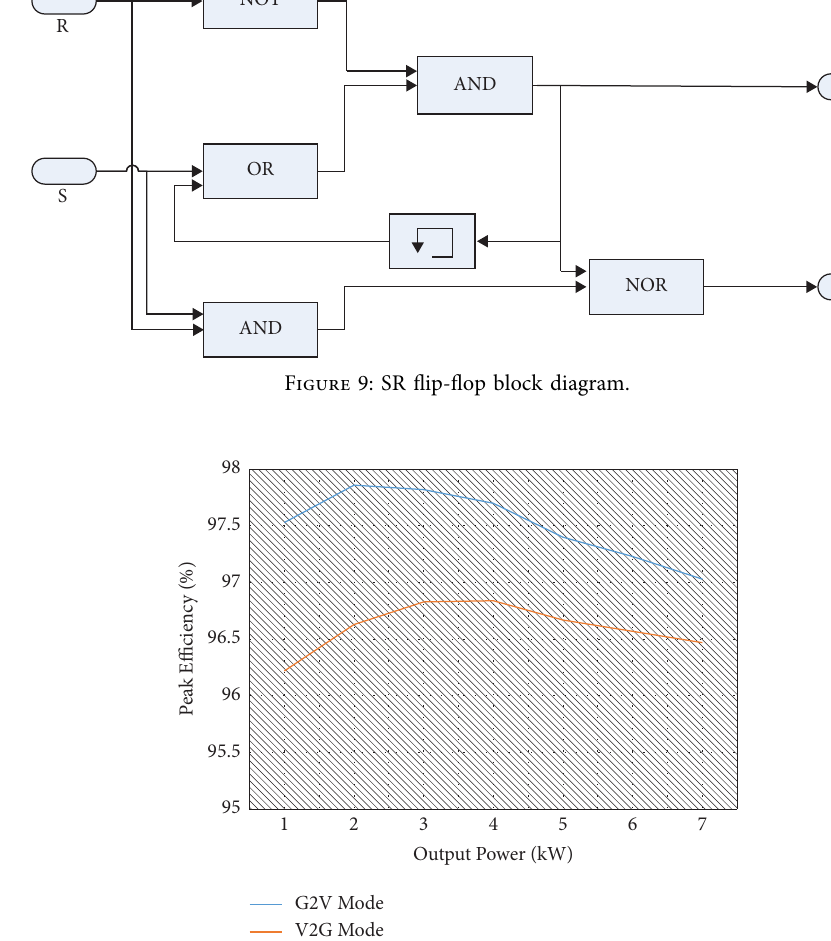
Figure 10: Efciency curves of CLLL converter utilizing GaN devices under varying load